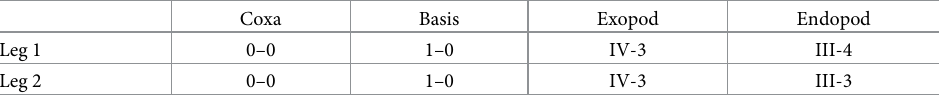
Body (Fig 6A) with broad flattened prosome. Average length of 10 specimens measured 260 (248–268) μ m (excluding seta) and greatest width 93 (91–95) μ m. Prosome 2-segmented. Cephalothorax distinctly longer than wide, 130 × 93 μ m; second prosomal somite wider than long, 68 × 33 μ m. Urosome (Fig 6A and 6B) 3-segmented, from anterior to posterior 85 μ m. Third segment longest, about 38 μ m in length and 24 μ m in width. Caudal ramus (Fig 6A–6C) small, about 15 × 11 μ m, bearing with 6 setae, innermost terminal seta longest, consisting of thicker proximal part and slender distal flagellum. Surface of body unornamented (Fig 6A). Antennule (Fig 6D) 4-segmented, with setal formula: 6, 4, 2+1 aesthetasc, and 6+1 aesthe- tasc, all setae naked. Antenna (Fig 6E) 4-segmented, consisting of coxobasis and 3 endopodal segments, each endopodal segments with 1 claw and 1 seta; exopod vestigial and unarmed. Labrum (Fig 6F) with concave posterior margin and well developed rounded lateral lobes. Mandible, maxillule, and maxilliped absent. Legs 1 and 2 (Fig 6G–6I) biramous, each ramus with 1-segmented exopods and endopods. Formula of spines (in Roman numerals) and setae (in Arabic numerals) as follows: